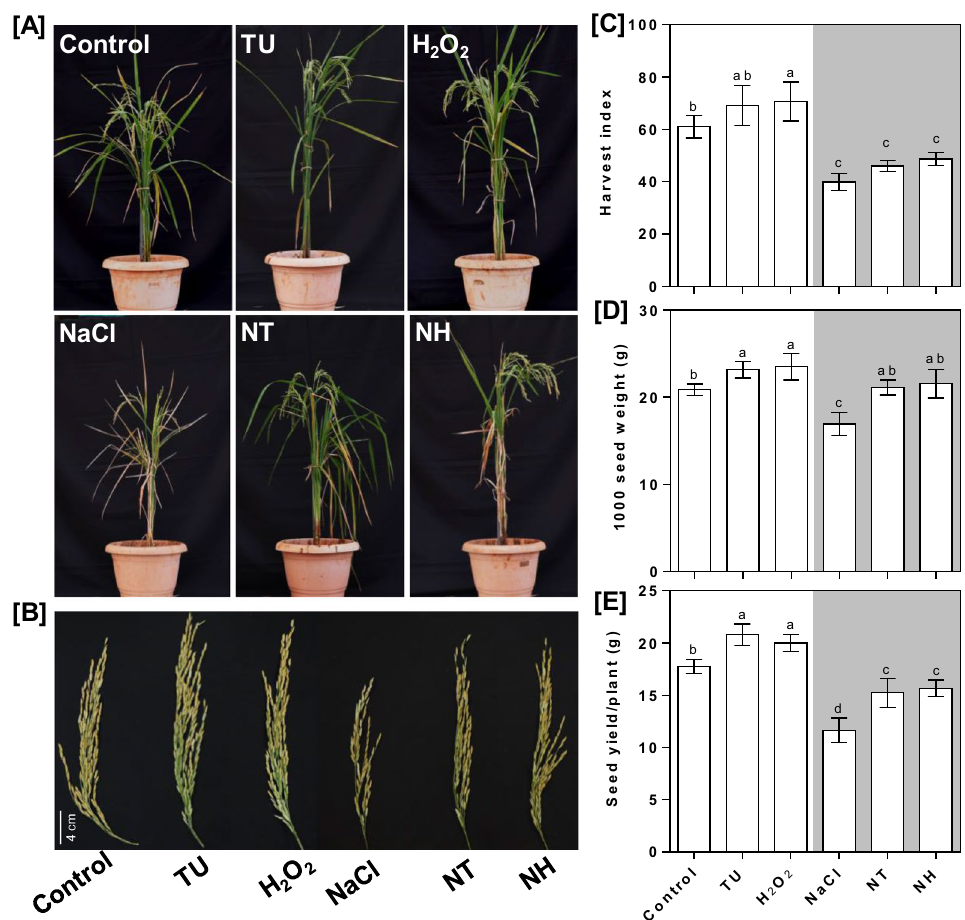
Figure 4. Effect of foliar-applied TU and H 2 O 2 treatment on plant growth and yield attributes. Pot-studies were performed under different treatments including WS (DW + 0.01% Tween-20), TU (6.5 mM TU + 0.01% Tween- 20) and H 2 O 2 (10 mM H 2 O 2 + 0.01% Tween-20), NaCl (22 g NaCl per pot). NT and NH denote combined treatment of NaCl + TU and NaCl + H 2 O 2 treatments, respectively. A total of three foliar applications were given at vegetative, early anthesis and grain filling stages that corresponded to 40, 55 and 72 days post-transplantation, respectively. At the time of maturity, the differential phenotype was recorded ( A ) and representative panicles were shown ( B ). In addition, the yield parameters such as harvest index ( C ), seed yield per plant ( D ) and 1000 seed weight ( E ) were also quantified. All values represent mean of 10 plants ± S.E. Different letters indicate significantly different values (DMRT, p ≤